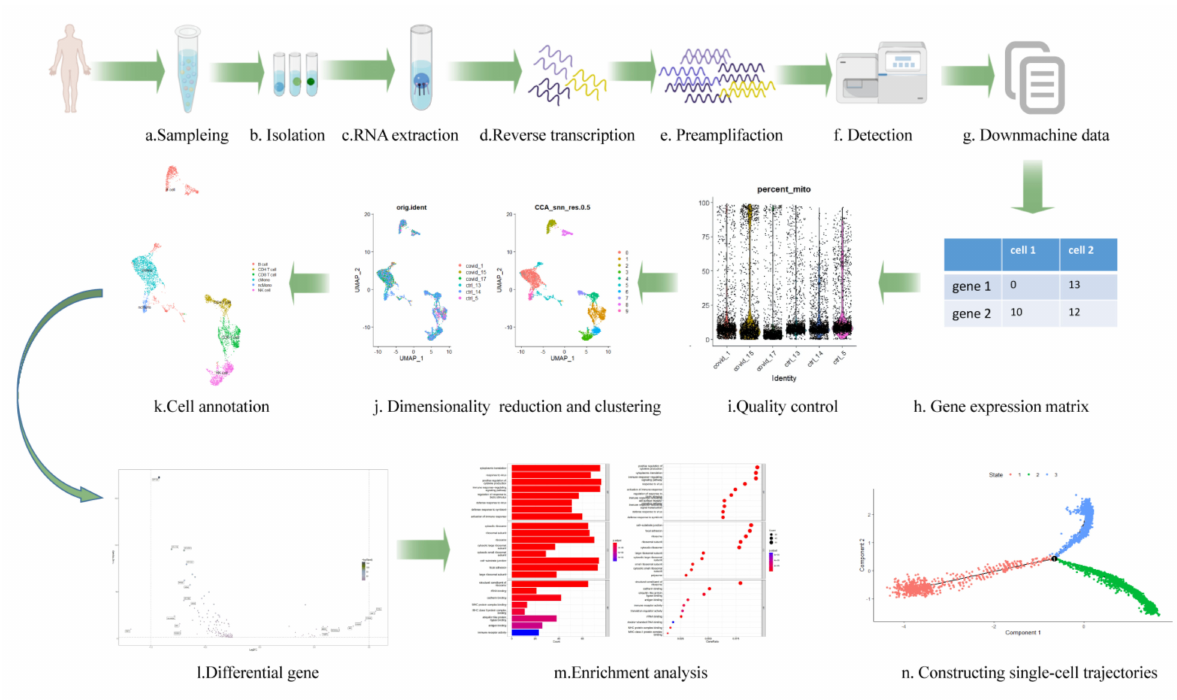
Figure 1. The acquisition and analysis of single cell data. The first row depicts the entire data collecting process ( a – g ). The second and third lines represent the procedure of downstream analysis. After build the gene expression matrix ( h ), quality control is carried out according to the proportion